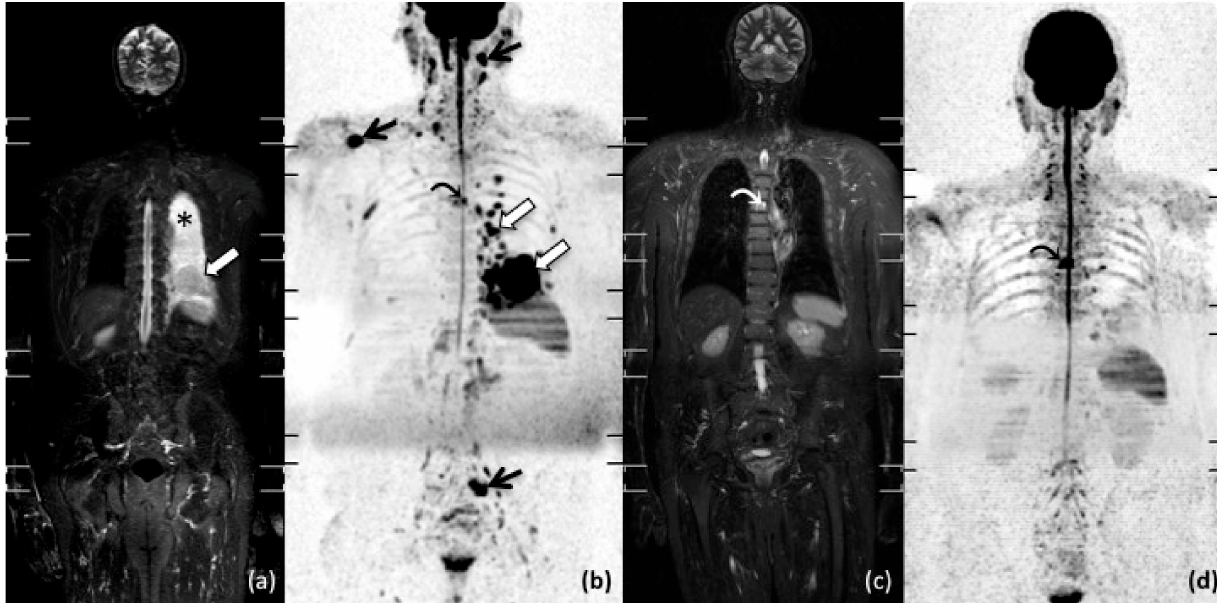
Figure 4. Whole-body MRI of a 62-year-old man with pleural non-Hodgkin Mantle Cell Lymphoma. Pre-treatment coronal short tau inversion recovery (STIR) ( a ), maximum intensity projection (MIP) b 800 grey-scale inverted DWI ( b ); post-treatment coronal STIR ( c ); and MIP b 800 grey-scale inverted DWI ( d ). Pre-treatment images show multiple pleural (white arrow in ( a , b )) and nodal (black arrow in ( b )) locations of disease with complete response after treatment ( c , d ); also note the presence of pleural effusion (* in ( a )), and a vertebral hemangioma with no changes after chemotherapy (curved arrow in ( b – d